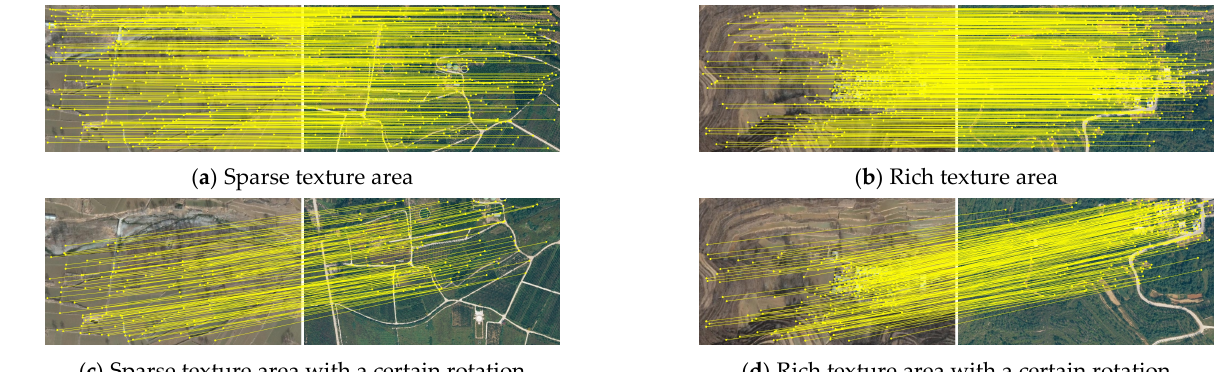
Figure 14. Partial matching results of Superpoint + CSAM on the test dataset.